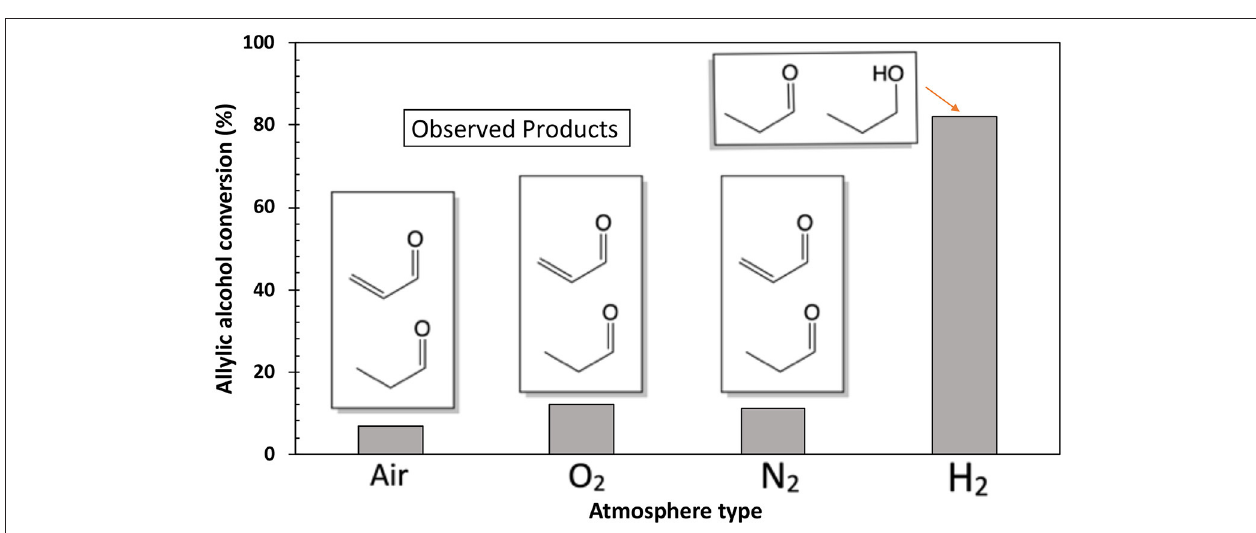
FIGURE 7 | Atmosphere effect in allyl alcohol conversion. Reaction conditions: temperature of 90 ◦ C, 1 bar pressure, 10h of reaction, 10ml of toluene, 3.44 mmol of allyl alcohol, and 5% of the C–Ru/Al catalyst.